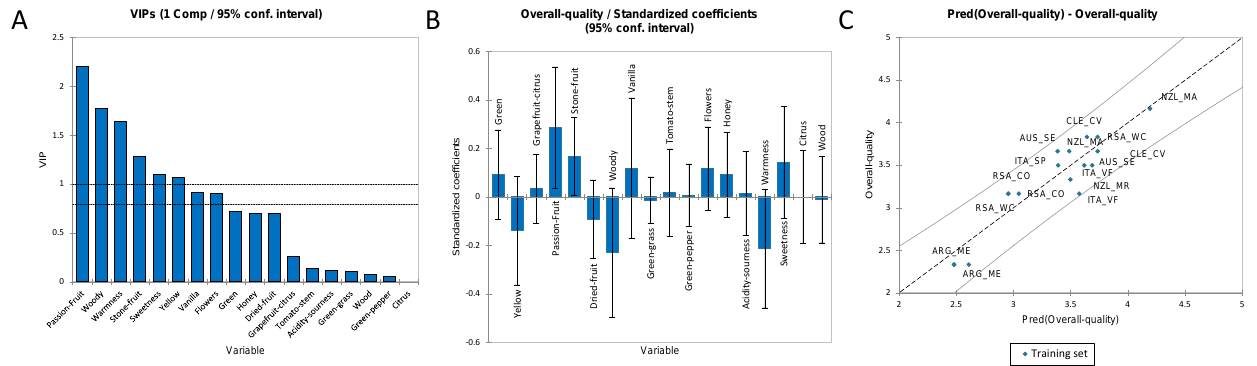
Figure 8. PLS data for the Overall Quality Judgment of Sauvignon Blanc wines. ( A ) shows the VIP for the sensory variables, ( B ) shows the effect of the variables on the PLS equation and ( C ) shows the regression for the OQJ vs. predicted